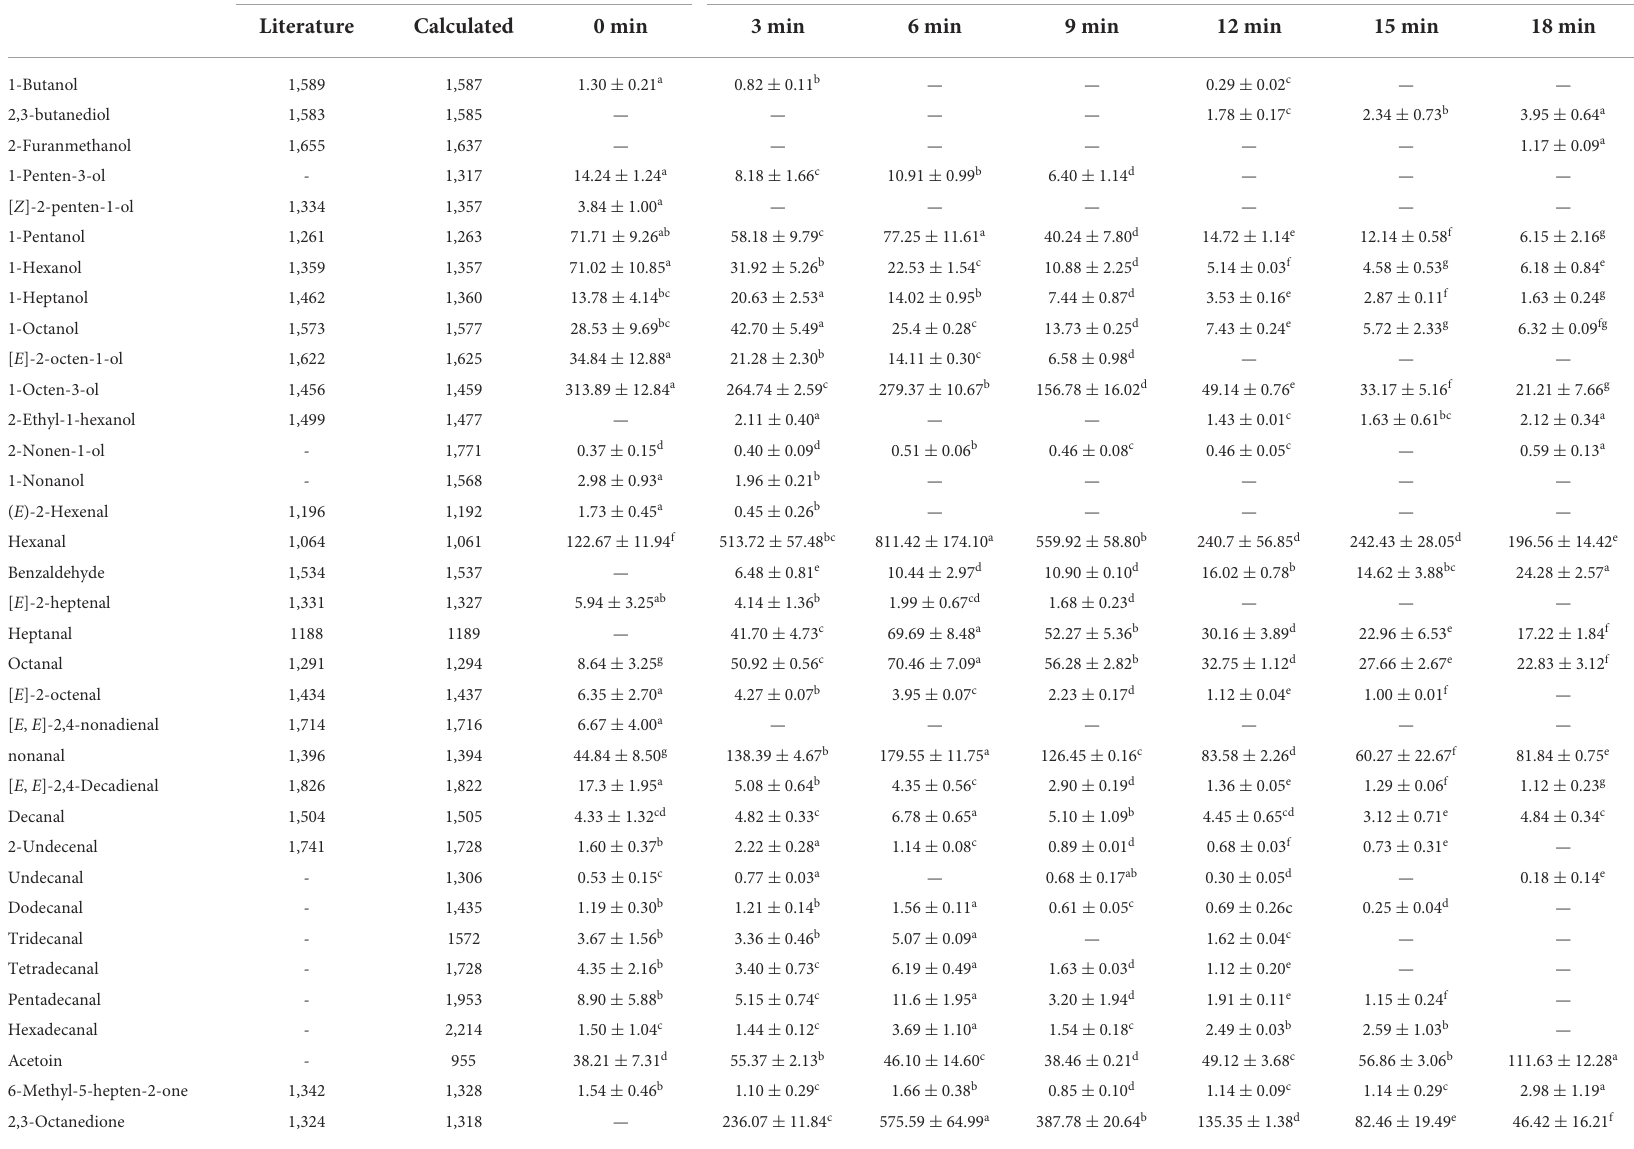
TABLE 2 The concentrations of volatile compounds in the roasted beef.